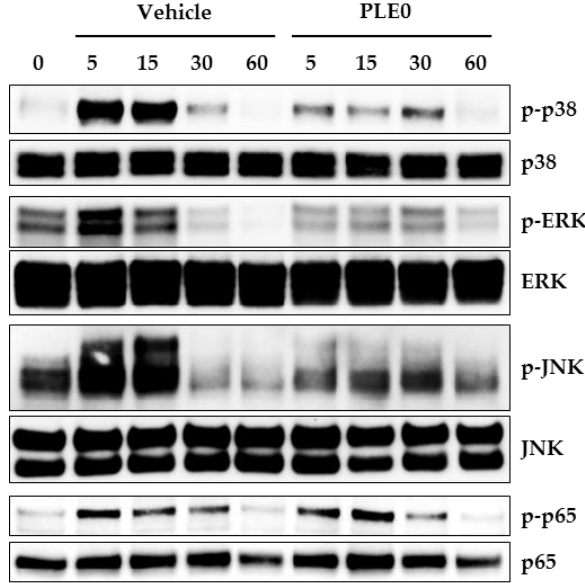
Figure 5. Effects of PLE0 on RANKL-induced activation of MAPKs and NF-kB. RANKL (100 ng/mL)-stimulated BMMs were incubated for the indicated periods of time with or without PLE0 (25 μ g/mL). Whole-cell extracts were subjected to Western blot analysis with specific antibodies as indicated. p-JNK, phospho-JNK; p-ERK, phospho-ERK; p-p38, phospho-p38; p-p65, phospho-p-p65.